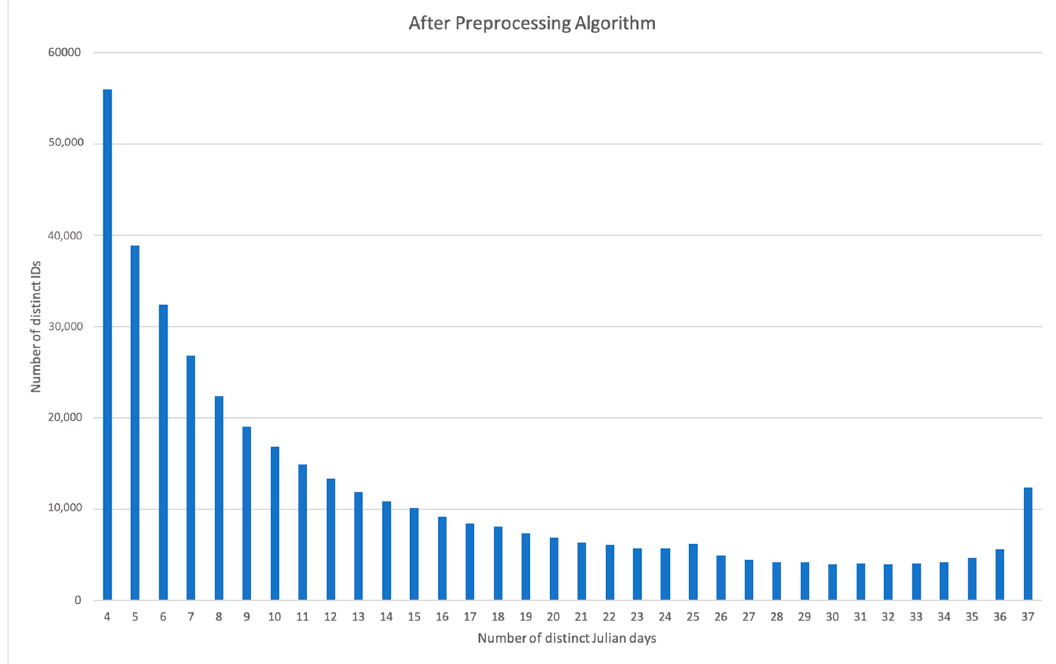
Figure 7. Preprocessing the data removed 369,839 unique IDs that did not have at least one record for four unique days prior to the earthquake. The original total of 774,343 (Figure 6) unique IDs was reduced to